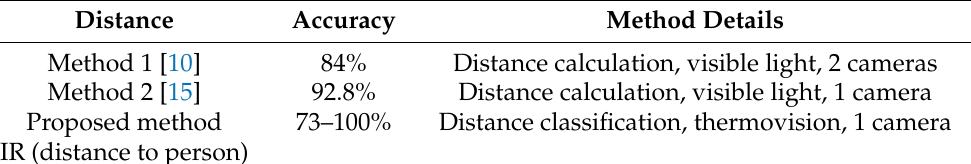
Table 2. Comparison of effectiveness of distance-detection methods with proposed